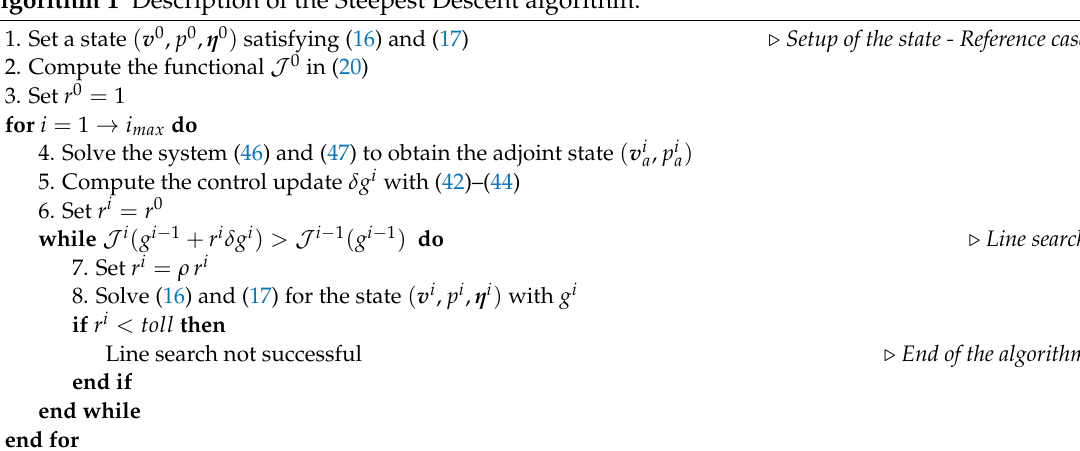
Algorithm 1 Description of the Steepest Descent